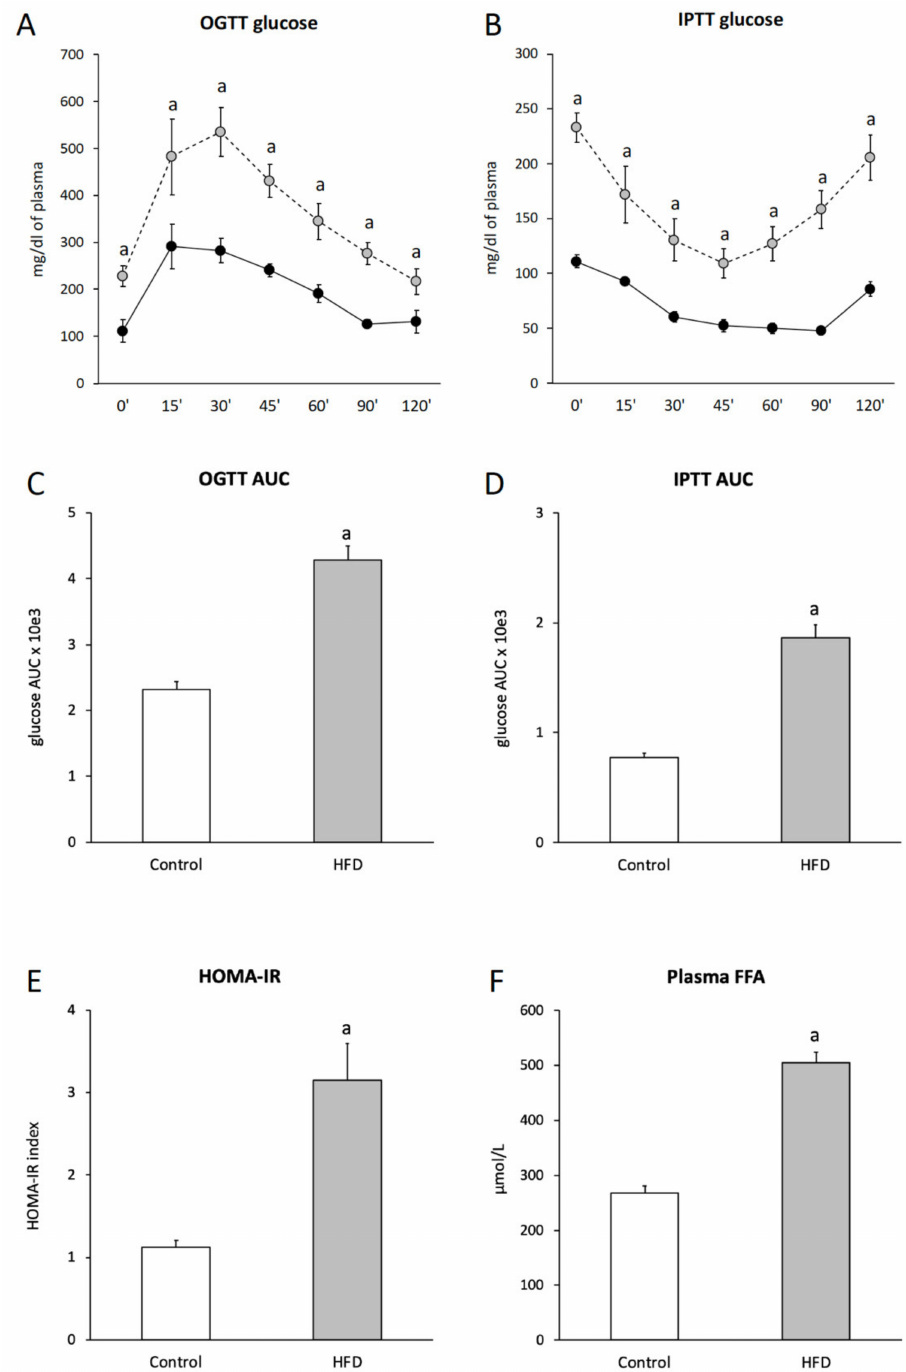
Figure 1. Impact of high-fat diet (HFD) consumption on plasma glucose and plasma fatty acid concentration. Panel A —plasma glucose profile during oral glucose tolerance test (OGTT); Panel B —plasma glucose profile during intraperitoneal insulin tolerance test (IPTT); Panel C —area under the plasma glucose curve for OGTT; Panel D —area under the plasma glucose curve for IPTT; Panel E —HOMA-IR value; Panel F —plasma free fatty acids (FFA). Values are mean ± SD ( n = 8 per group); a— p < 0.05 vs. control; significance by t -test; HFD-High-fat